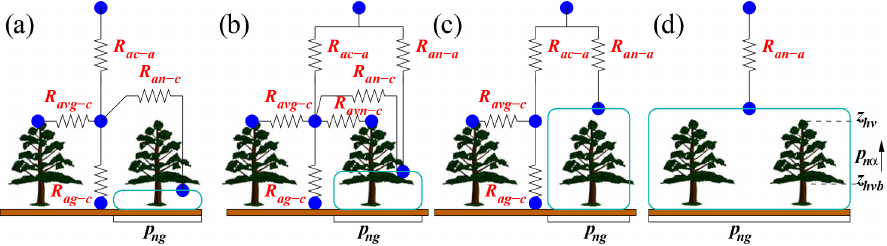
Figure 2. A schematic sketch illustrating the role of p n α , the fraction of the vegetation canopy, which is buried by ground-based snow. In panel (a) , the snow is well below the canopy base, z hvb , resulting in p n α = 0, and the snow has no direct energy exchange with the atmosphere. In panel (b) , the canopy is partly buried by snow (0 < p n α < 1) and the snow has energy exchanges with both the canopy air and the atmosphere. In panel (c) , the canopy is fully buried by snow ( p n α = 1) and the snow has energy exchange only with the atmosphere, whereas the soil and canopy only exchange with the canopy air space ( p ng < 1). Finally, in panel (d) , both p ng = 1 and p n α = 1 so that the only exchanges are between the snow and the